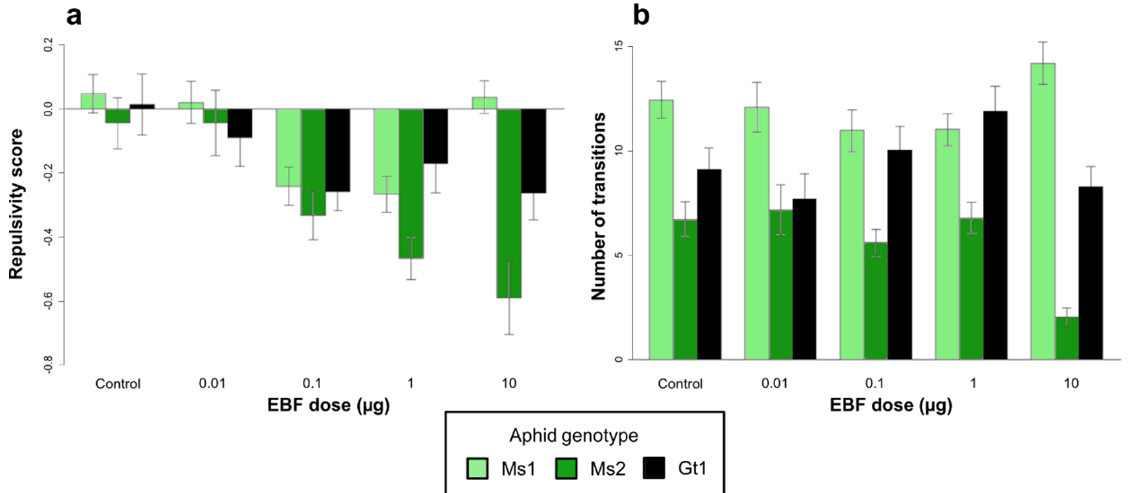
Figure 1. Repulsivity score ( a ) and number of transitions in olfactometer ( b ) at different E- β farnesene (EBF) doses for three Acyrthosiphon pisum genotypes free of secondary symbionts (i.e., Ms1, Ms2, and Gt1). Error bars show the standard error. N = 30 aphids for each stimulus and line.